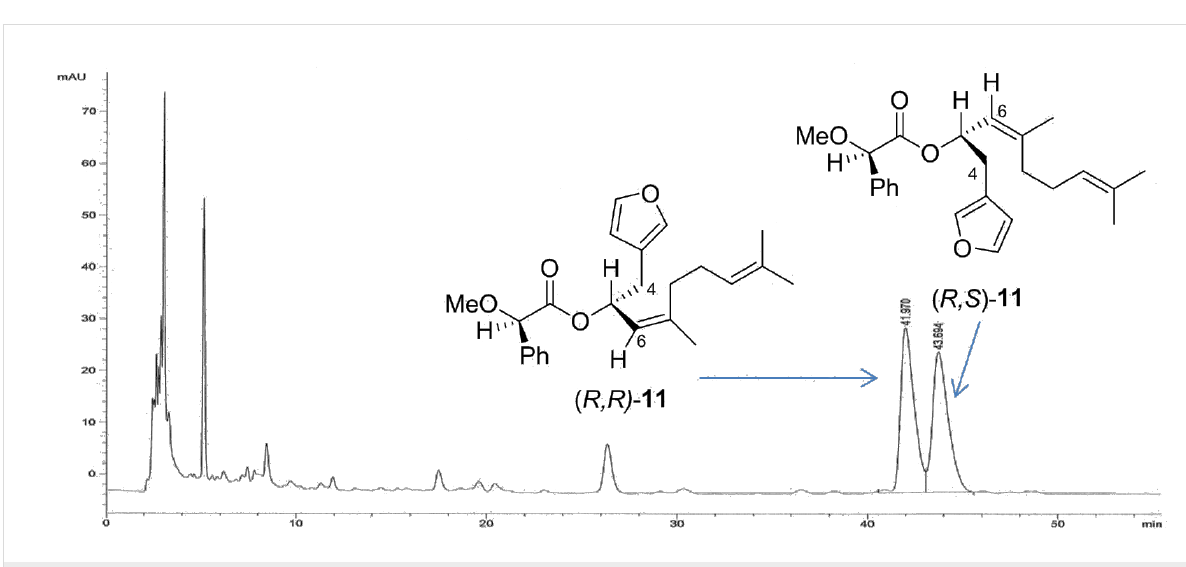
was identical to that of the synthetic ( R,R )- 11 and